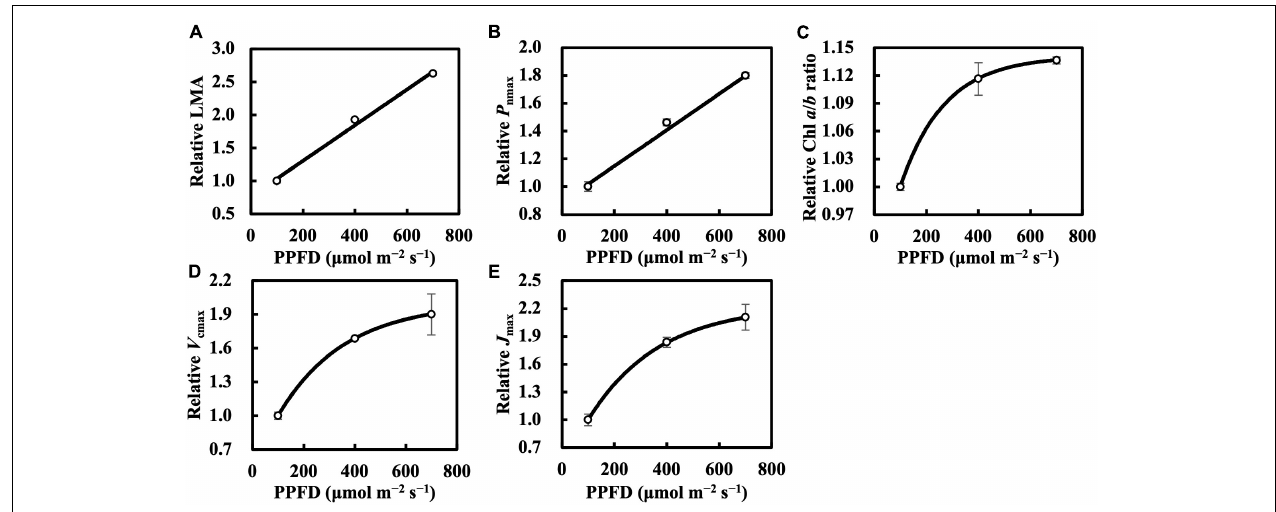
FIGURE 1 | Relative leaf mass per area (LMA) (A) , maximum net photosynthetic rate ( P nmax ) at C a of 400 µ mol mol − 1 (B) , chlorophyll (Chl) a / b ratio (C) , maximum rate of ribulose-1,5-bisphosphate carboxylase/oxygenase ( V cmax ) (D) , and maximum rate of electron transport ( J max ) (E) of the first true leaves of cucumber seedlings grown under constant daily photosynthetic photon flux density (PPFD) levels for 6 days. All values were means ± standard errors ( n = 3) and relativized to that for 100 µ mol m − 2 s − 1 . Measured values (open circles) and estimated values (solid line) fitted with linear (A,B) or asymptotic (C–E) functions are shown. See section “Statistics” for details of asymptotic functions.